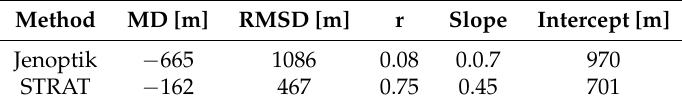
Skill scores (MD—mean deviation; RMSD—root-mean-square deviation, r—Pearson correlation coefficient, slope—linear regression slope, intercept—linear regression intercept ) of aerosol-based algorithms (Jenoptik and STRAT) compared against the Richardson method as a reference in the MLH determination.